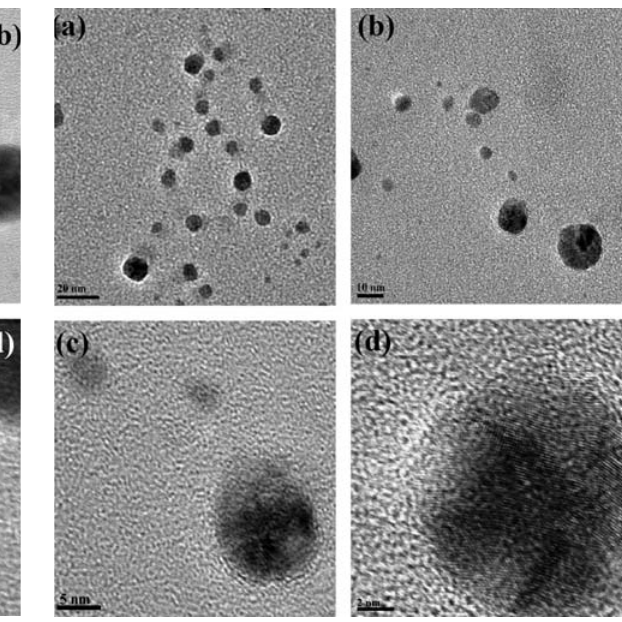
Figure 5. TEM micrograph of the g3